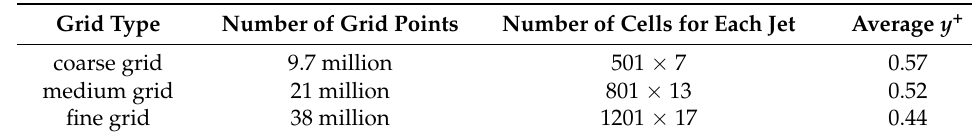
Table 2. Grids for the grid convergence study.